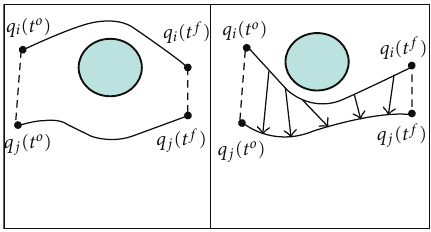
Figure 3: Frames depict an example of a combination of G ∗ , q o , and q f which are not feasible. Loops in left and right frames are not in the same homotopic equivalence class.